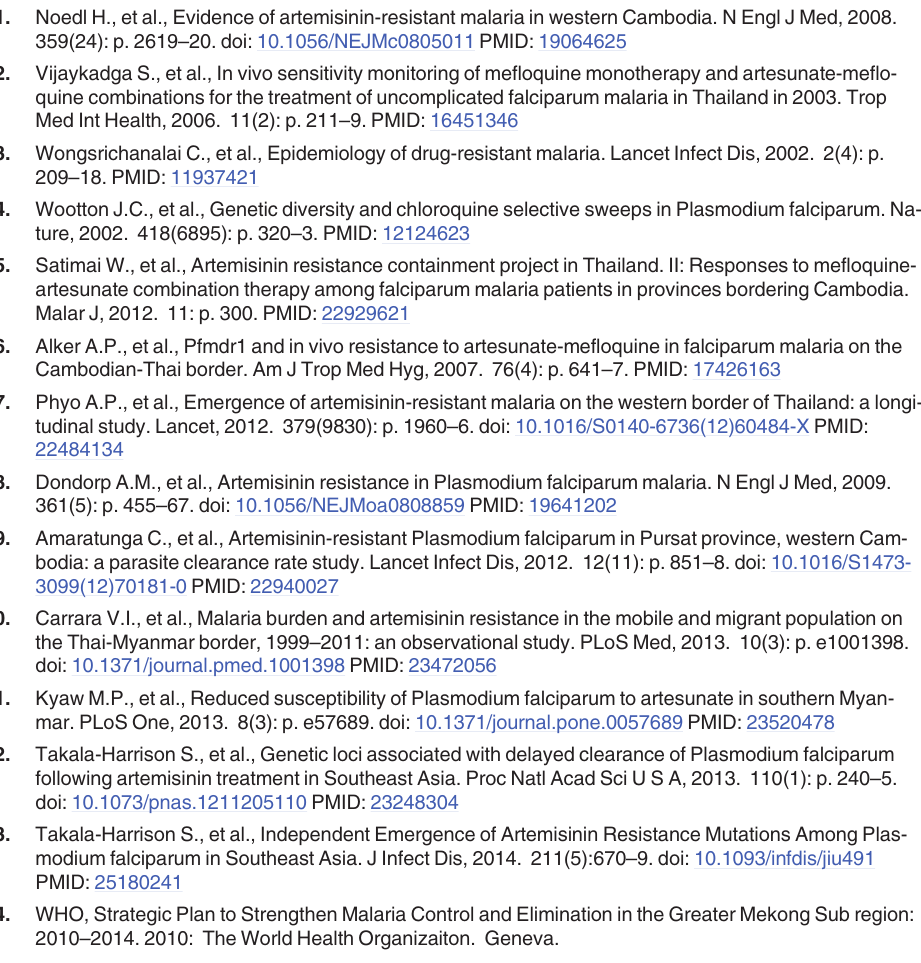
S1 Table. Table with microsatellite primers tested.